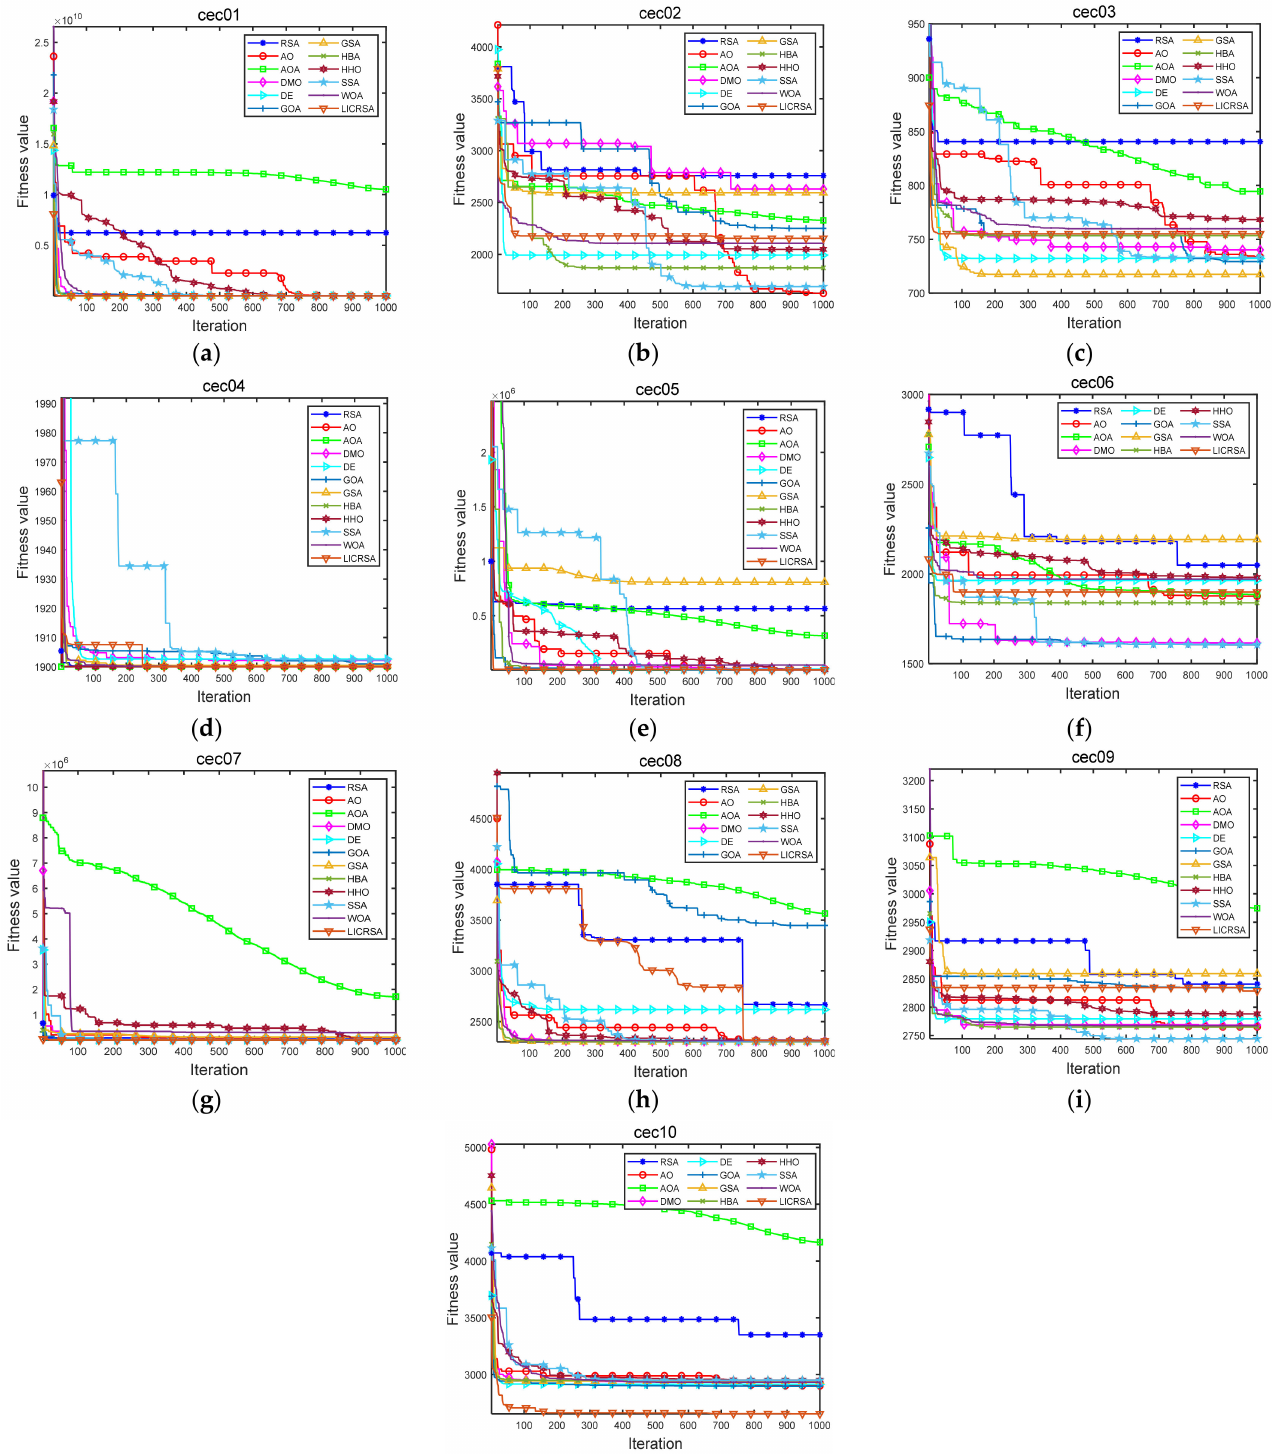
Figure 9. The convergence curves of the LICRSA and search algorithms on CEC2020: ( a ) cec01; ( b ) cec02; ( c ) cec03; ( d ) cec04; ( e ) cec05; ( f ) cec06; ( g ) cec07; ( h ) cec08; ( i ) cec09; ( j )